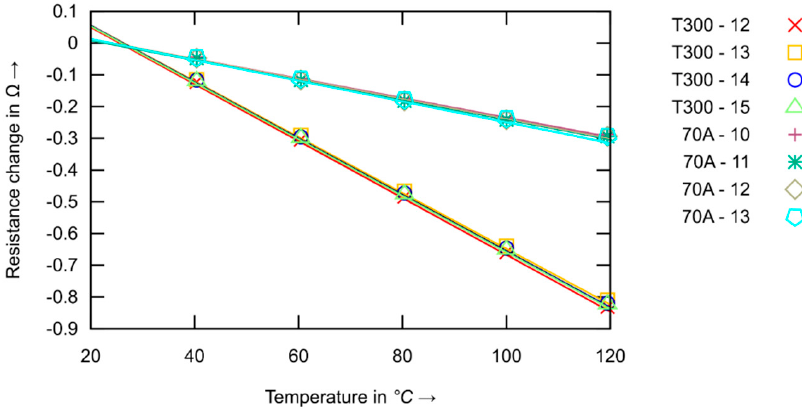
Figure 5. A linear fit function for the measured mean values of the CFS. A linear fit model was chosen, seen Equation (2), with the slope of the linear fit m , the resistance at 0 °C of the CFS R 0°C , and the measured resistance of the CFS R T . T CFS = (R T – R 0°C )/m . (2) The calculated coefficients of the linear model, and also the R 2 and root mean squared error (RMSE) values, are summarized in Table 4. The high R 2 values show, that the CFS signals show good linear behavior. The RMSE values show the magnitude of the error between the linear fit function and the measured mean values of the CFS samples. Table 4. The calculated values of the linear fit, and also the R2 and RMSE values. Specimen Nos.